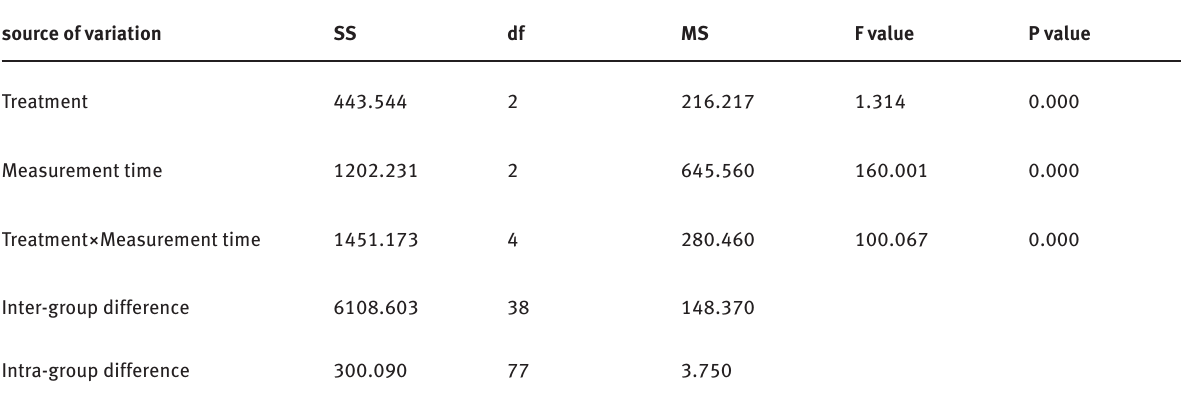
Table 4: Variance analysis of ma value of the patients in the three groups at different times